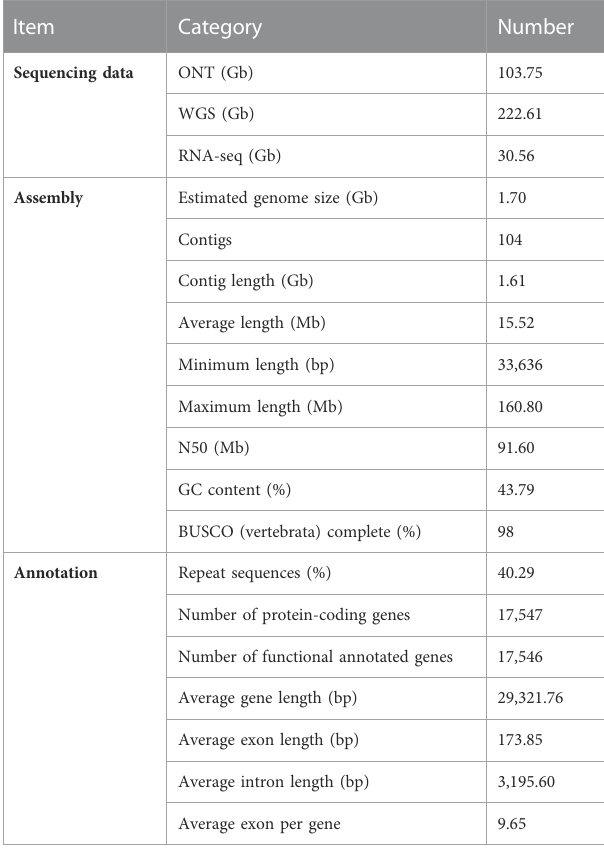
TABLE 1 Summary of genome assemblies and gene annotations of Calotes versicolor draft